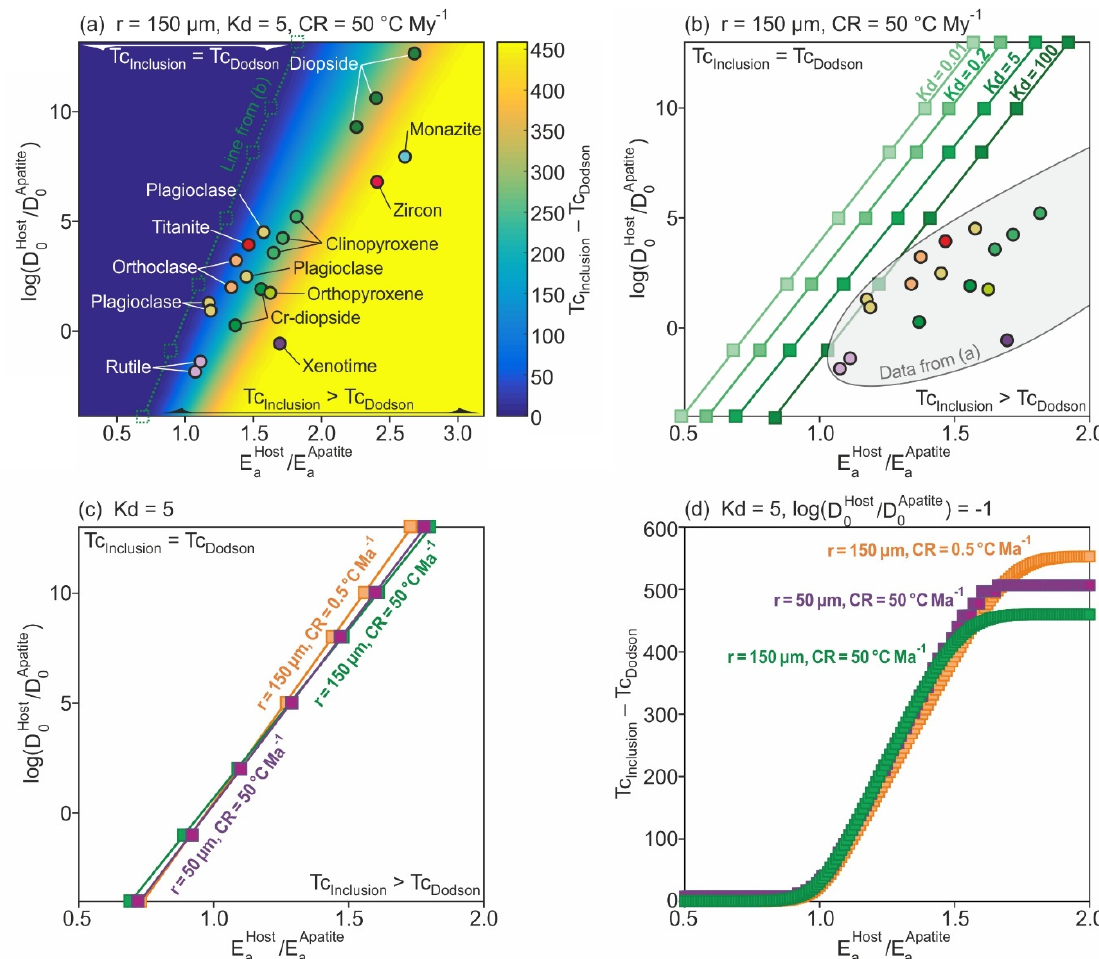
Figure 3. A comparison of Tc Inclusion and Tc Dodson for chemically homogeneous spherical apatite inclusions in different host minerals. ( a ) The dependence of the difference between Tc Inclusion and Tc Dodson on diffusion properties of the host mineral for fixed r, Kd and CR. The green dotted line indicates the transition from open (Tc Inclusion = Tc Dodson ) to flux-limited (Tc Inclusion > Tc Dodson ) boundary behaviour. Data points for different minerals show the available experimental data on Pb diffusion parameters [51–54]. Marker fill colours are used to highlight separate determinations from the same mineral. ( b ) The dependence of the transition from open to flux-limited boundary behaviour on Kd for fixed r and CR. ( c ) The dependence of the transition from open to flux-limited boundary behaviour on r and CR for a fixed Kd. ( d ) The dependence of the difference between Tc Inclusion and Tc Dodson on E a Host /E a Apatite for different r and CR and fixed Kd and log(D 0Host /D 0Apatite ). Tc Inclusion –Tc Dodson values plateau towards higher E aHost /E aApatite values because Tc Inclusion reaches the modelled crystallisation